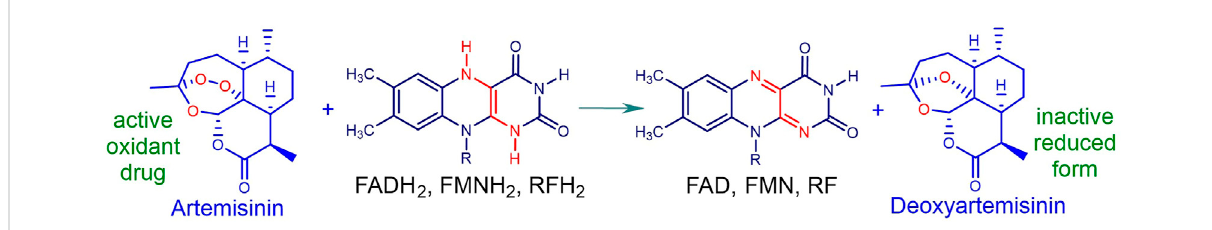
FIGURE 2 Oxidation of reduced fl avins by artemisinin: FAD fl avin adenine dinucleotide, FMN fl avin mononucleotide, RF ribo fl avin. Formal two-electron transfer results in irreversible reduction of the artemisinin to deoxyartemisinin. Thereby, scavenging of electrons from the reduced fl avin within the fl avin disul fi de reductase e.g., GR, TrxR, lipoamide dehydrogenase and others results in blockade of GSH supply. Abrupt build-up of reactive oxygen species (ROS) upon addition of the artemisinin that may be associated with induction of downstream signalling pathways results in enhanced oxidative stress ( cf. Figure 3